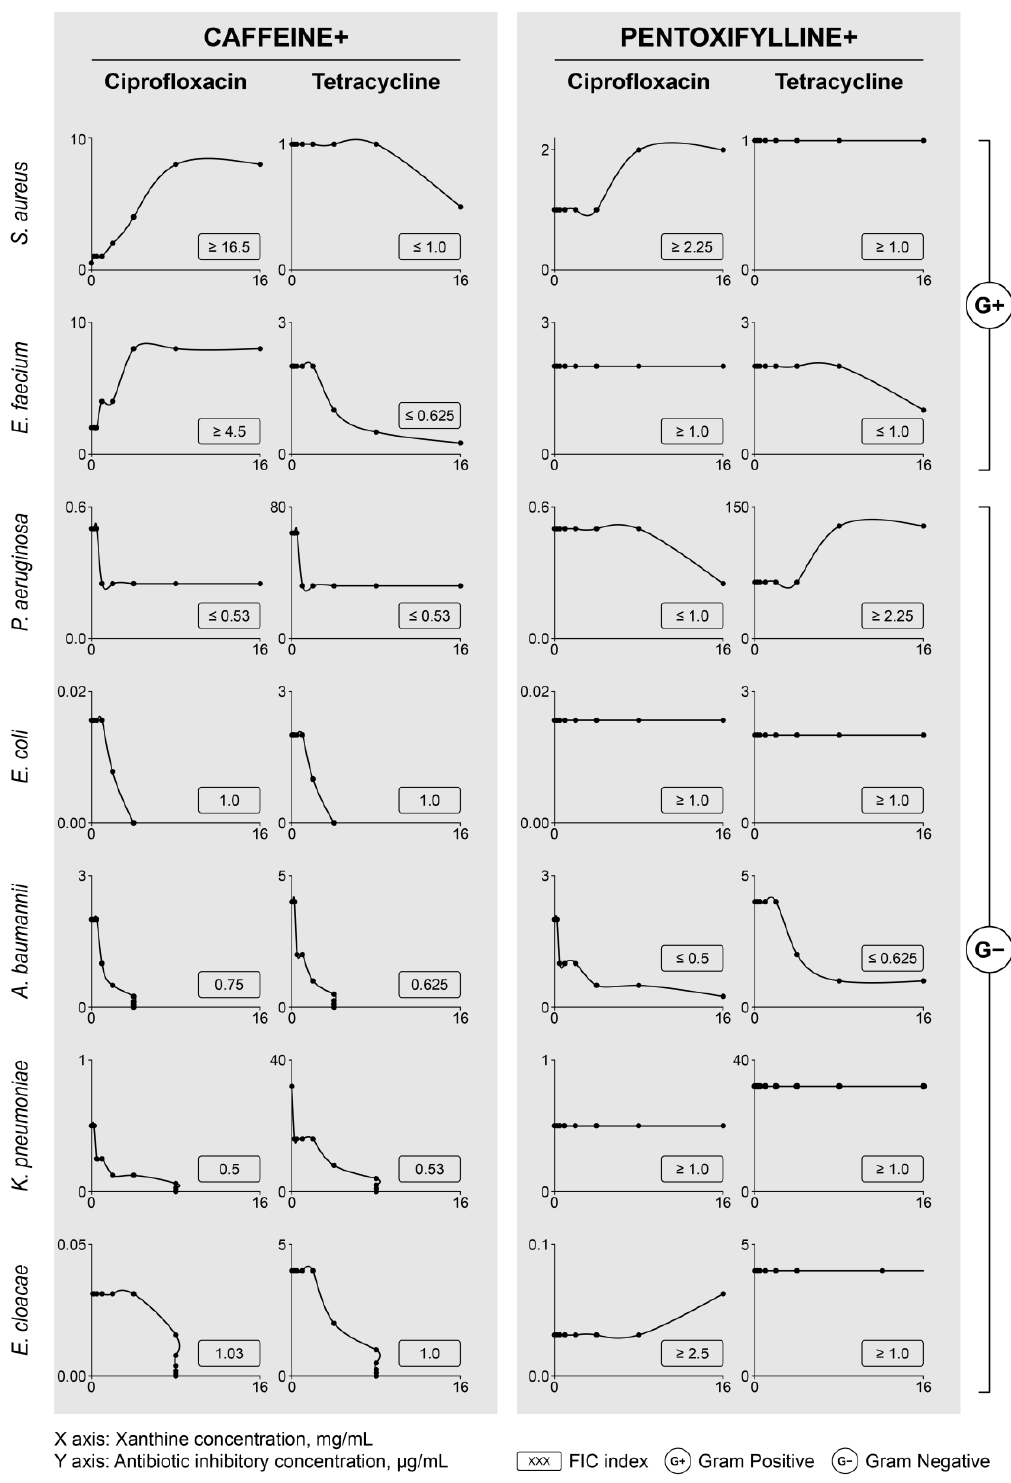
Figure 5. Dose-dependent modulation of antibiotics (ciprofloxacin and tetracycline) inhibitory potential by xanthines (caffeine and pentoxifylline) towards selected bacterial pathogens. Graphs represent isobolograms for each antibiotic- xanthine pair tested in concentration gradient of both compounds. Seven investigated pathogens are given as separate rows. Inhibitory concentrations given on Y axes correspond to minimal inhibitory concentration of tested antibiotics. FIC, Fractional Inhibitory Concentration Index, calculated for each tested antibiotic-xanthine combination according to Odds [33] .